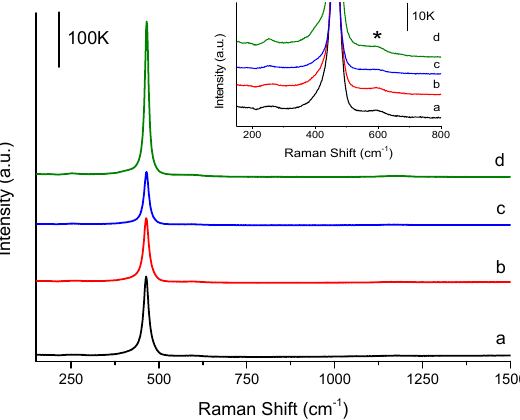
Figure 4. Raman spectra of the ceria samples calcined at different temperatures with F 2g mode at ca. 465 cm − 1 ; ( a ) 400, ( b ) 500, ( c ) 600 and ( d ) 700 °C. Insert highlights the relative intensity of the defect mode (*) at ca. 590 cm − 1 .